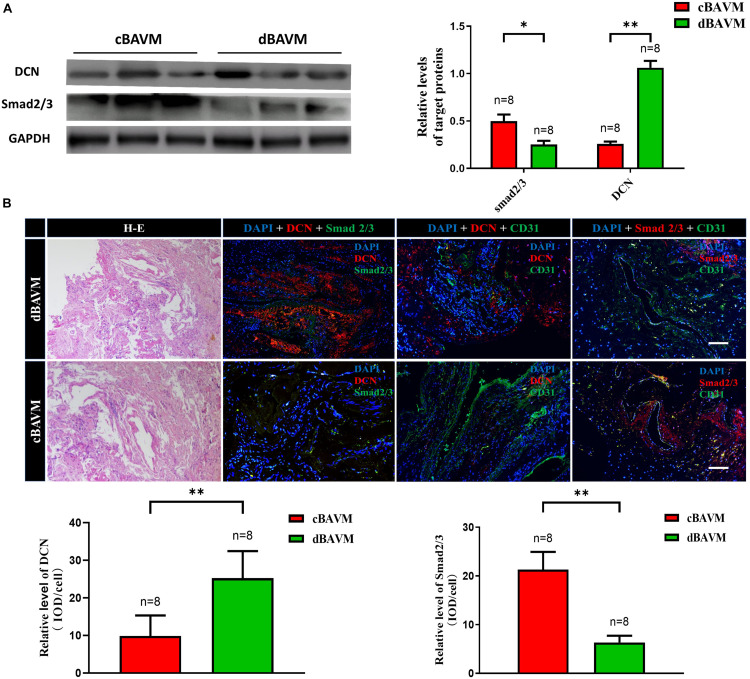
The expression level of DCN and Smad 2/3 in BAVM tissues. (A) Western blot analysis further validated the upregulation of DCN and downregulation of Smad 2/3 (Smad family member 2 and 3) in another six BAVM tissues (three cBAVMs and three dBAVMs; the information of these six BAVM patients was given in Supplementary Table 2). ∗P < 0.05; ∗∗P < 0.01. (B) Histological staining was performed in all 16 BAVM samples. Two groups of representative images of hematoxylin–eosin (H-E) and immunofluorescence staining for DCN, Smad 2/3, and CD31 in BAVM tissues. The histograms showed the semiquantitative grading of DCN and Smad 2/3 expression levels in diffuse and compact BAVMs. The scale bar corresponds to 200 μm. ∗∗P < 0.01.